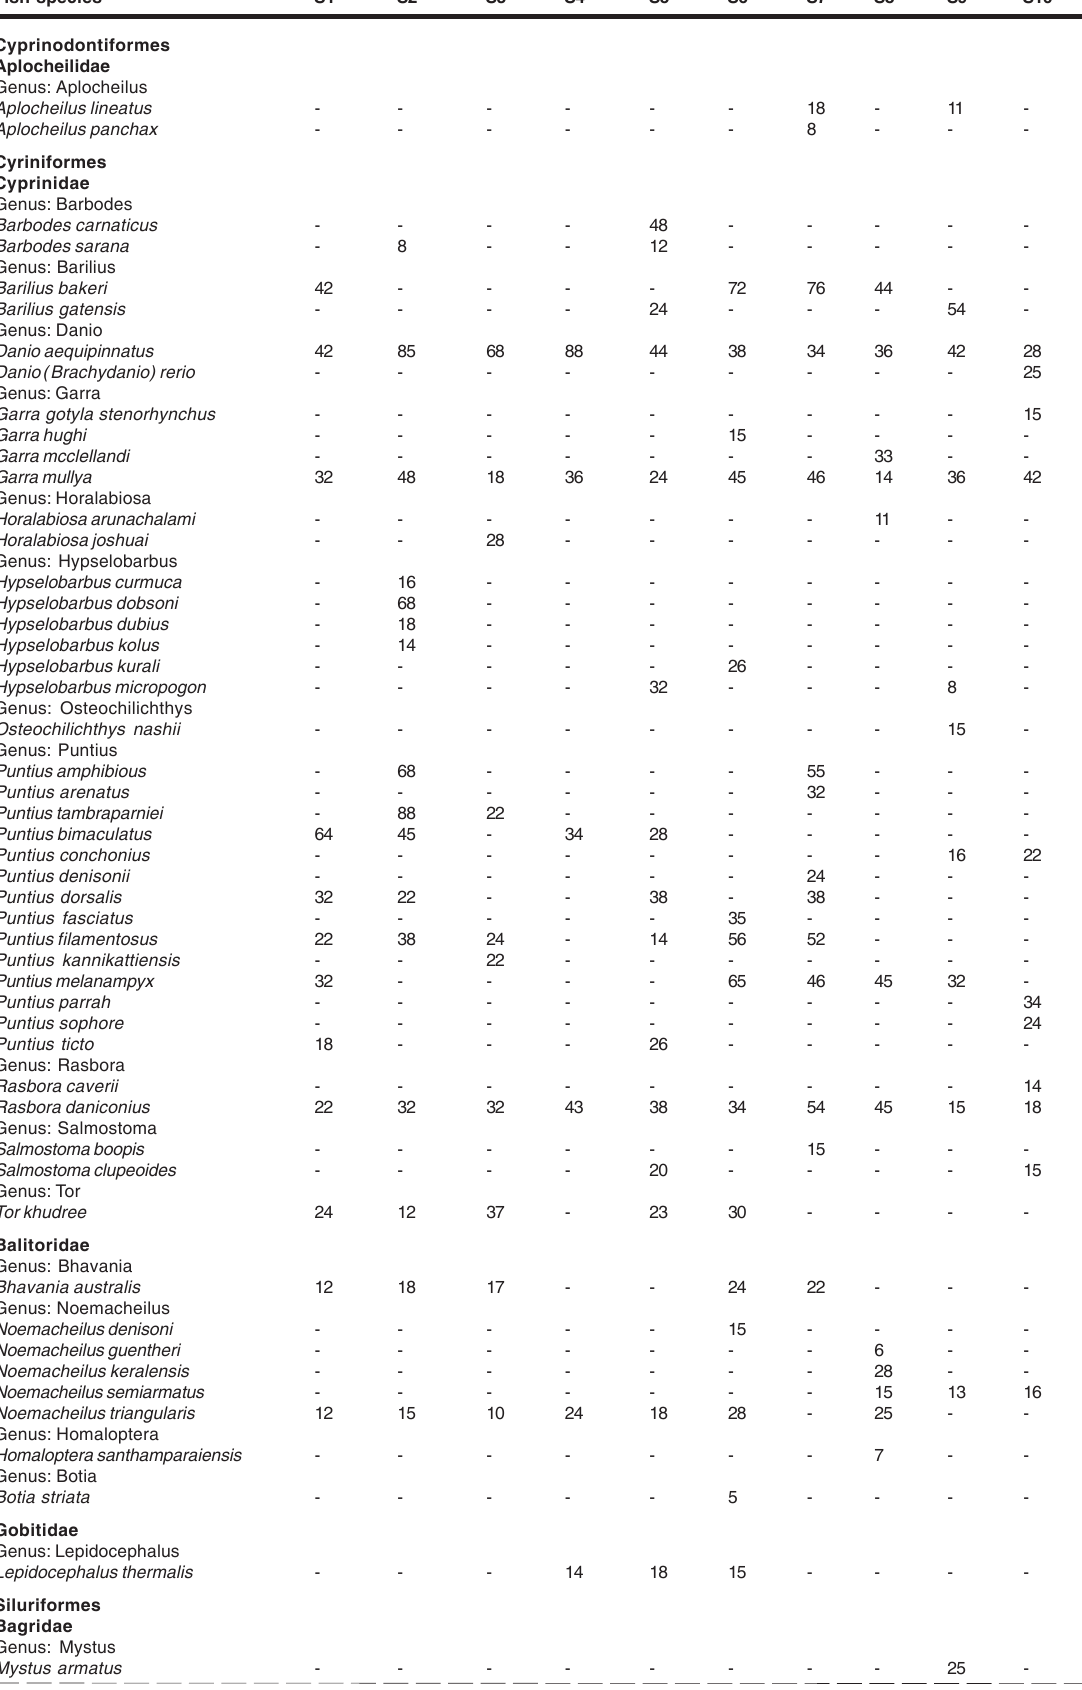
Table 2. List of fish species recorded from the study streams of Western Ghats. Fish